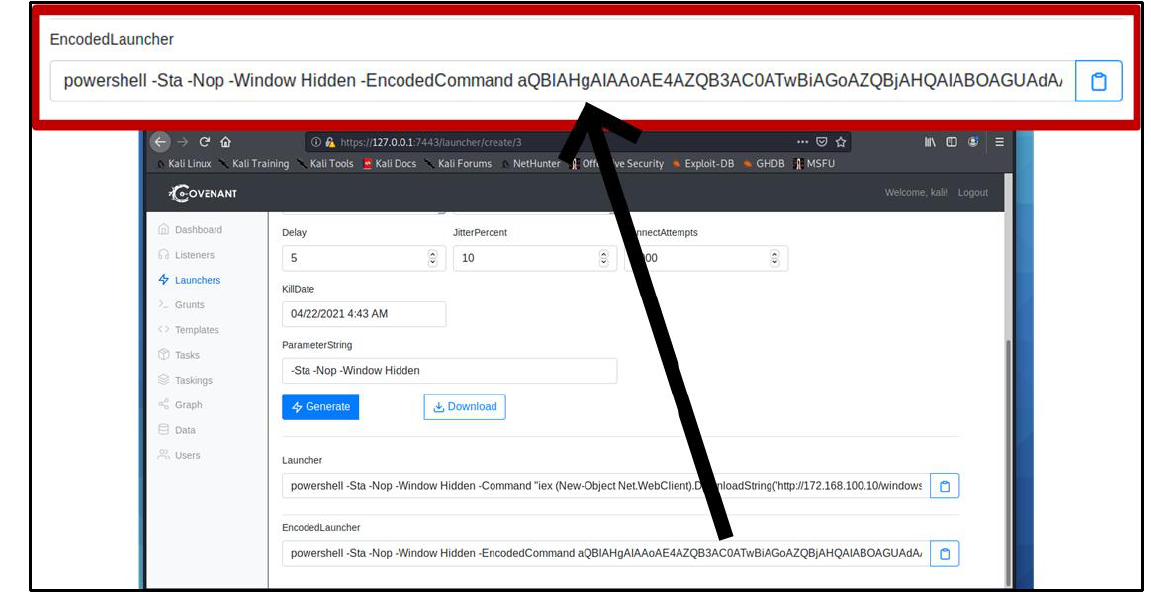
8 of 15 Figure 5. Malicious document execution process . 5. Results Experimental Scenario: Malicious Documents Malicious documents fall under social engineering [33], which can be defined as ma- licious activities that are facilitated through human interaction. The tactic uses psycholog- ical manipulation [34], which is the process of tricking a user to perform a certain task that will lead to the giving away of sensitive information or the opening of a backdoor that may compromise a system. The adversary first examines the target and gathers necessary information about an individual or company; then, the adversary searches for weak entry